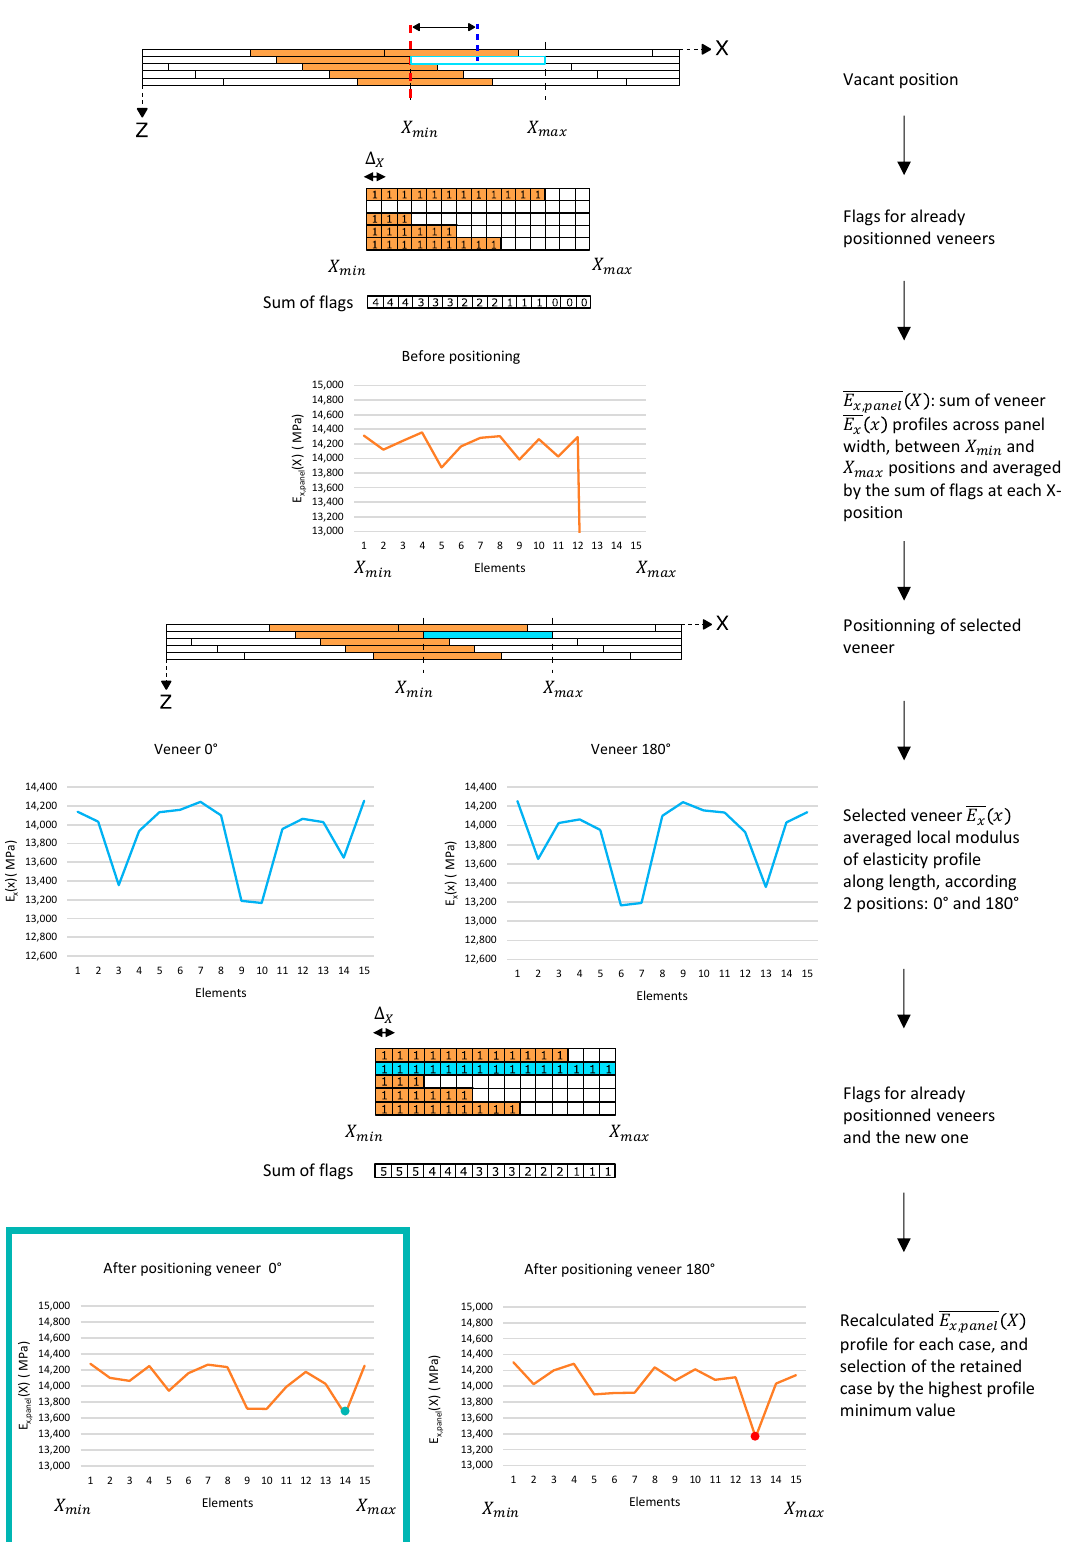
Figure 3. Nonsuperposition principle.